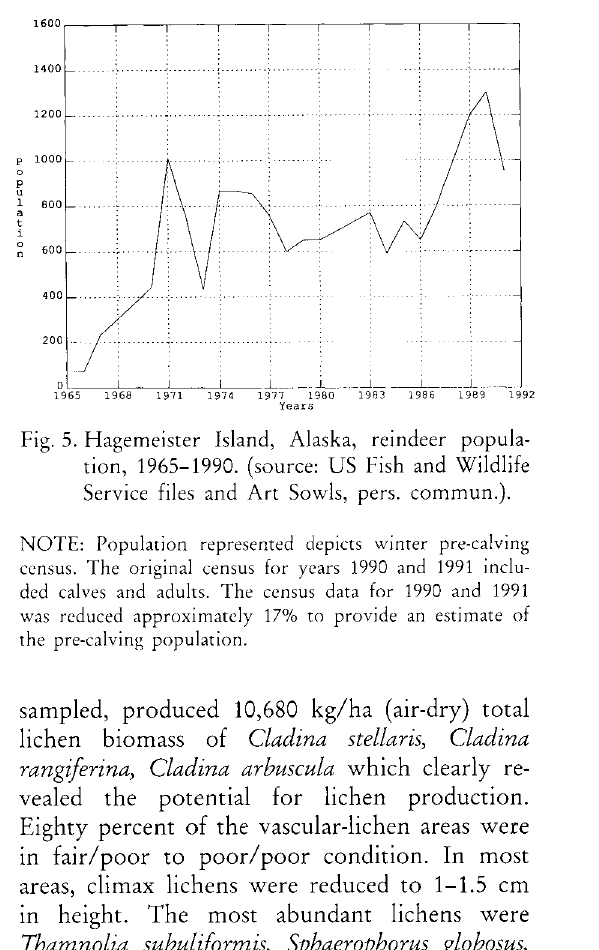
Fig. 5. Hagemeister Island, Alaska, reindeer popula tion, 1965-1990. (source: US Fish and Wildlife Service files and Art Sowls, pers.